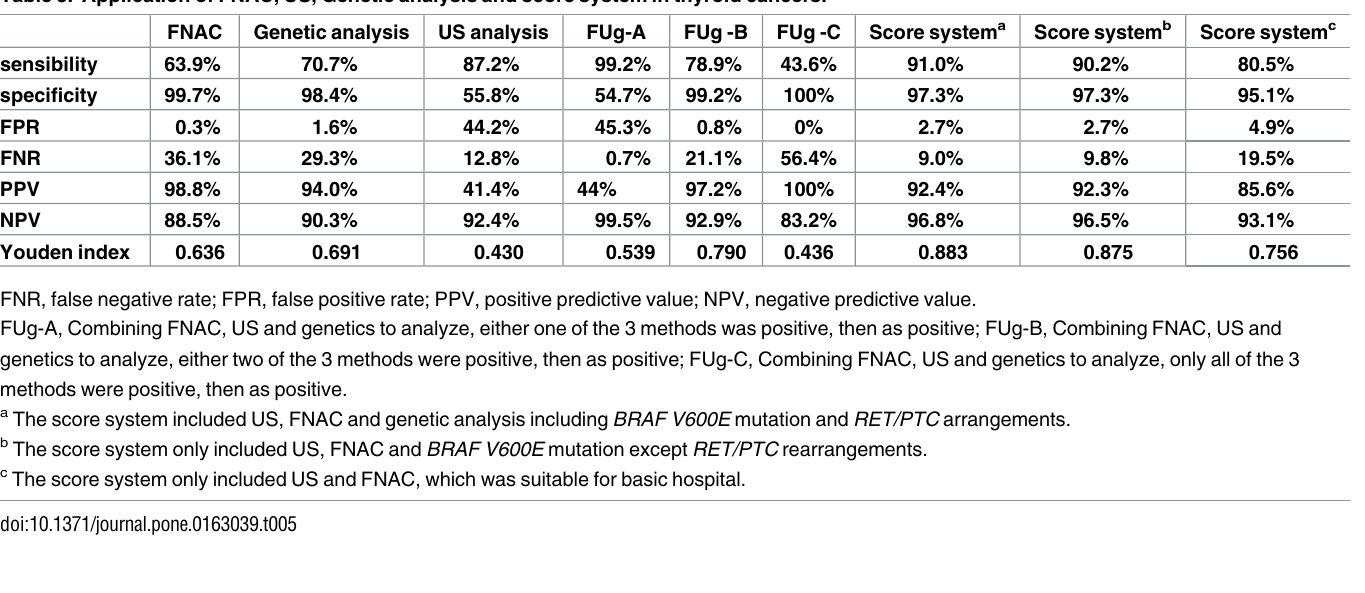
genetic analysis alone. We also combined FNAC-US-genetics (FUg) together for analysis, as shown in Table 5. FUg-A, FUg-B and FUg-C respectively denoted if either one, either two or all three of FNAC-US-genetics were positive, then it would be considered as positive. With the highest sensitivity but the lowest specificity of Fug-A and with the highest specificity but the lowest sensitivity of Fug-C, only FUg-B has medium sensitivity and specificity (78.9% and 99.2%, respectively) but with the highest youden index. However, comparing with scoring sys- tem a and scoring system b , FUg-B was obviously inferior due to the lower sensitivity and you- den index. It demonstrated that these two scoring systems had the best authenticity based on the youden index. US alone had relatively higher sensitivity (87.2%) but lower specificity (55.8%) and could be used for simple screening of large populations. Together, the above data demonstrated that scoring system a and scoring system b using cut-off values of 6.5 points